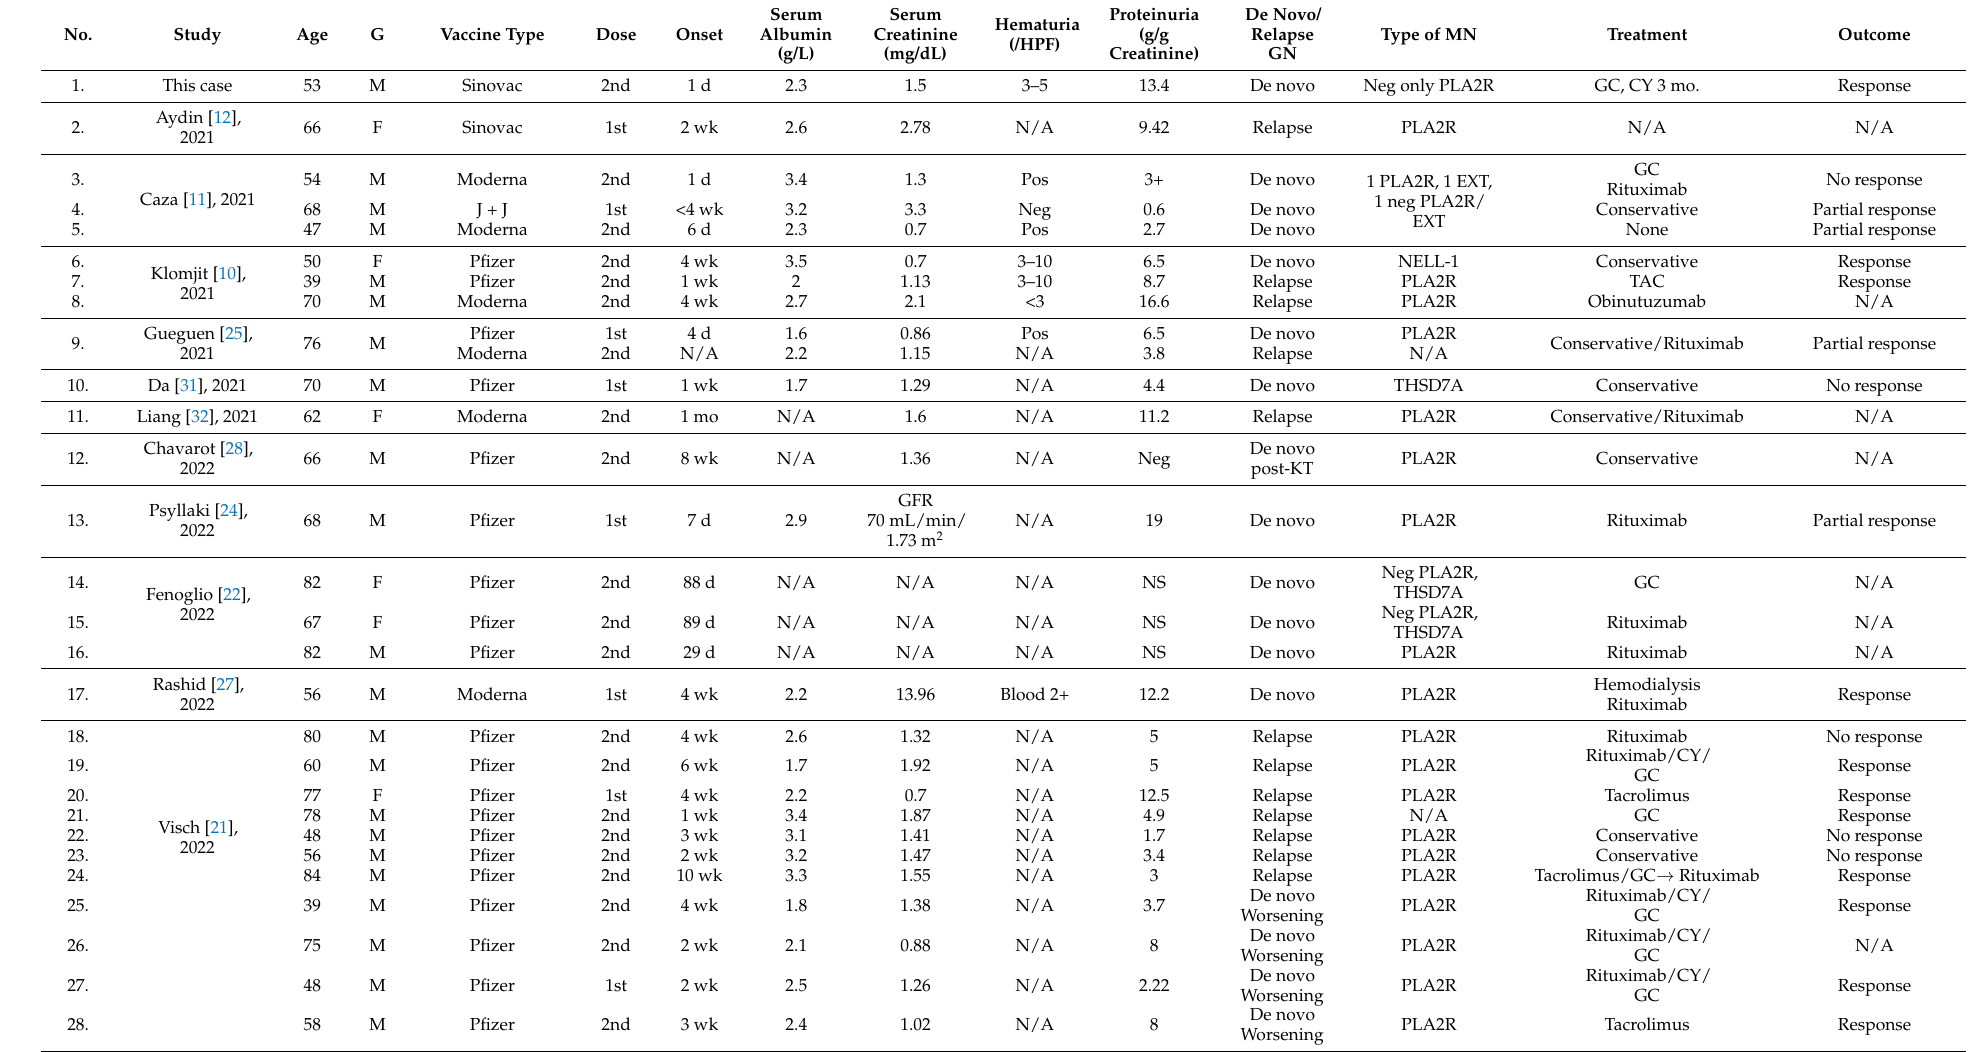
Table 1. Clinical spectra and outcomes of membranous nephropathy following SARS-CoV-2